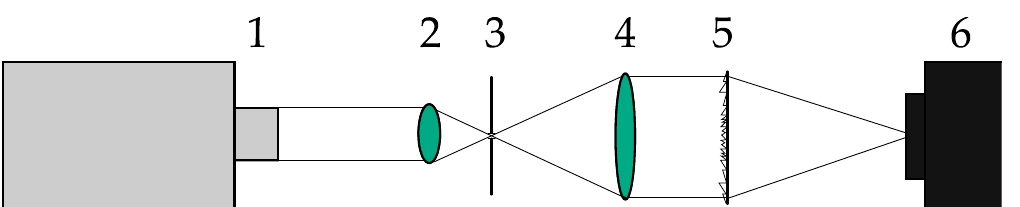
Figure 3. An experimental optical scheme for measuring the point spread function of the SDL: 1—a tunable laser NT-242, 2—a micro-objective, 3—a 10-µm pinhole, 4—a collimating lens, 5—an SDL, 6—a recording camera Basler acA 1920-40um (Basler, Ahrensburg, Germany).